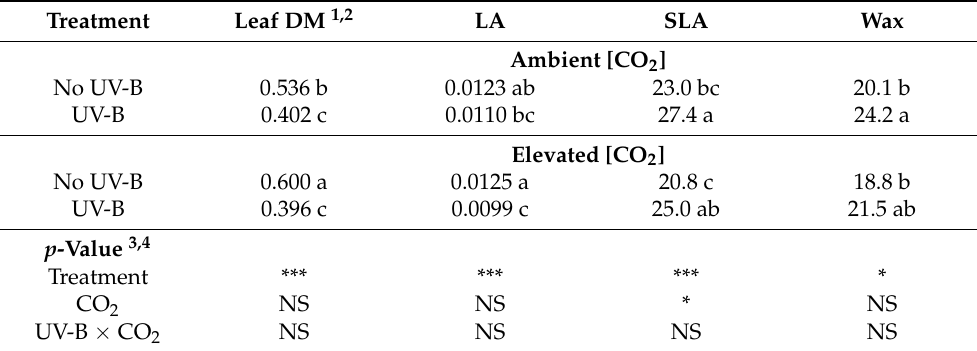
Table 4. The leaf dry mass (Leaf DM) and leaf area (LA) used to estimate the specific leaf area (SLA), and the mean epicuticular wax (Wax) of basil plants grown without UV-B radiation (No UV-B) and with 10 kJ m − 2 d − 1 UV-B radiation (UV-B) at 420 and 720 ppm CO 2 concentration (ambient [CO 2 ] and elevated [CO 2 ], respectively) after 38 days of